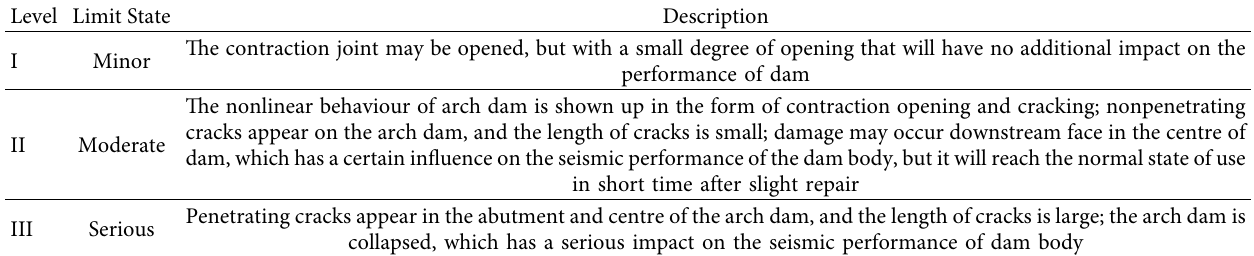
Table 3: Three limit state of arch dam.